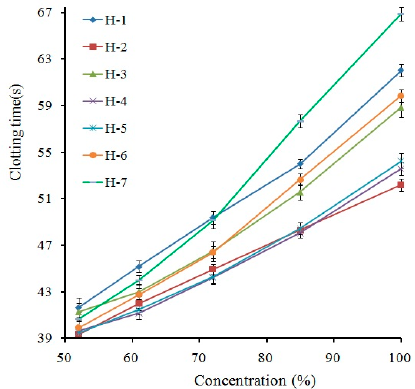
Figure 1. Activated partial thromboplastin time (APTT) effects of safflower injections produced by different companies. The clotting time is expressed as the mean of three measurements ± SD ( n = 3). Safflower injections were diluted with normal saline (NS) to create sample test solutions at five different concentrations: 100%, 85%, 72%, 61%, and 52%, with an inter-solution ratio of 0.85. H1–H7 denote seven different safflower injections produced by different companies.